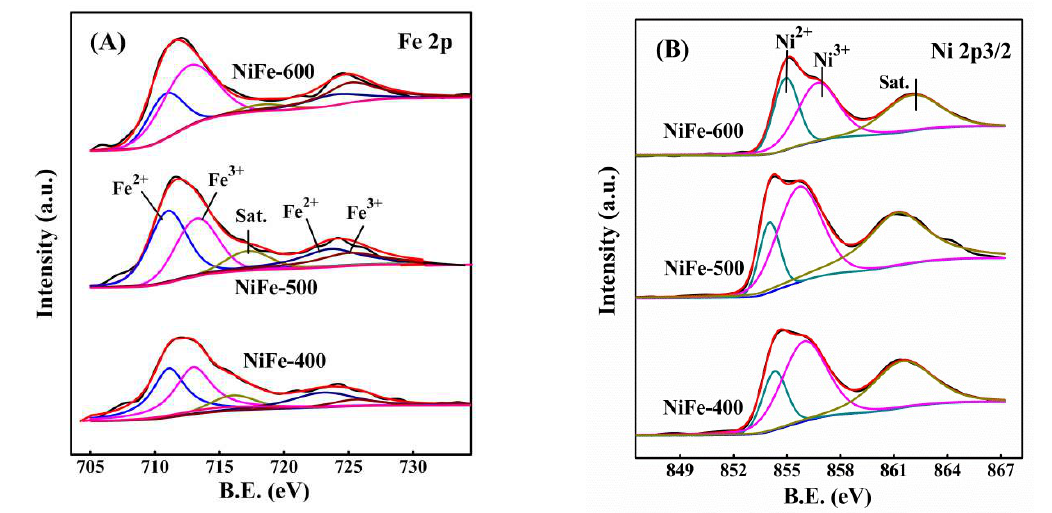
Figure 7. XPS spectra of the serial catalysts: ( A ) Fe 2p and ( B ) Ni 2p.